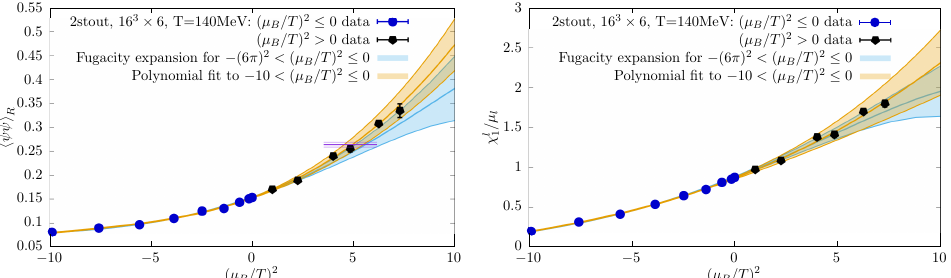
/ T ) 2 at temperature B